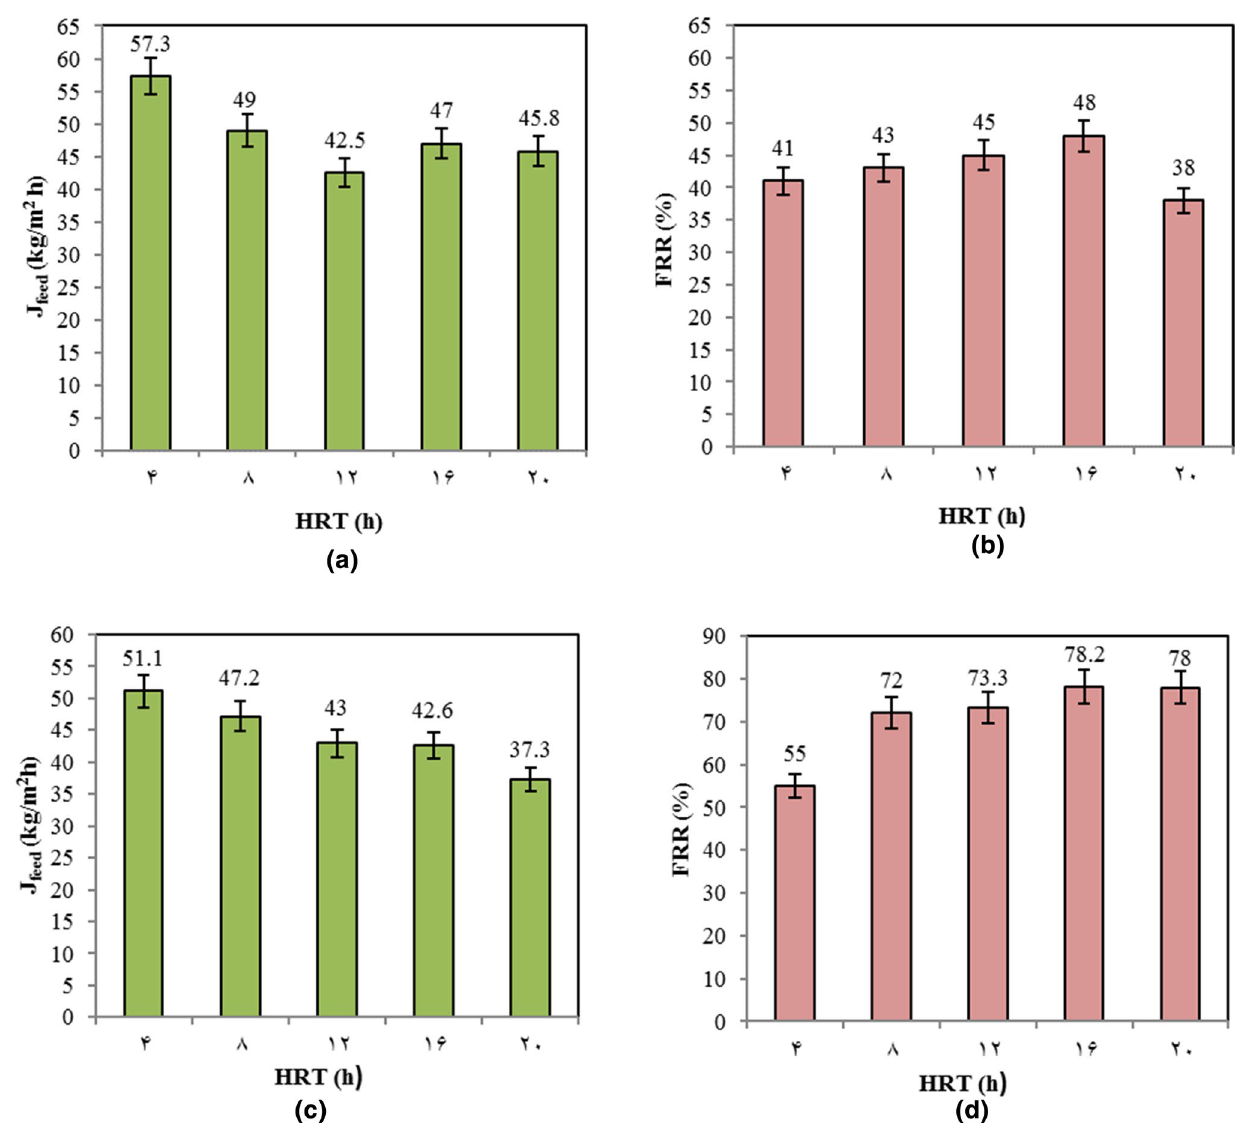
Fig. 4 J feed ( a ) and FRR ( b ) measured for MF membrane at constant pressure of 10 psi and